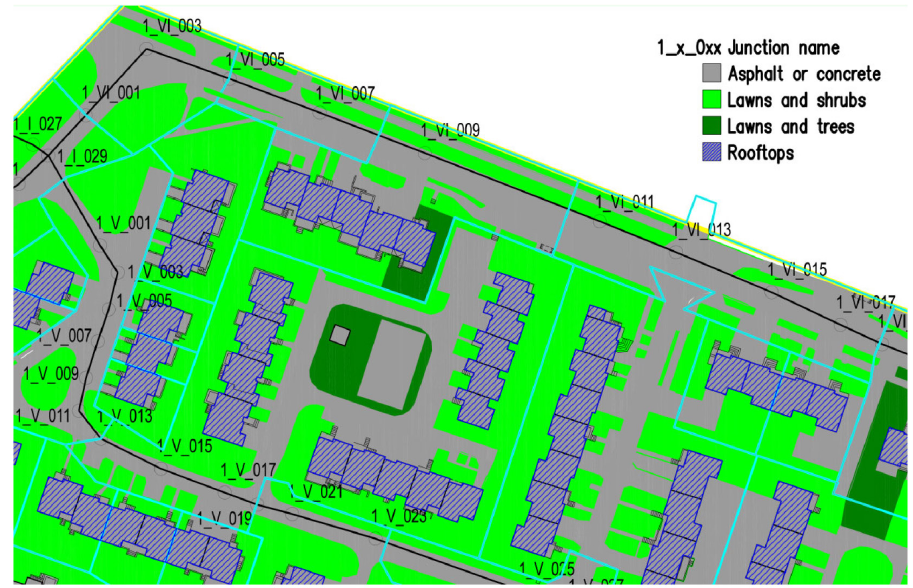
Figure 6. Areas covered by the system of rainwater collection and utilization within the property